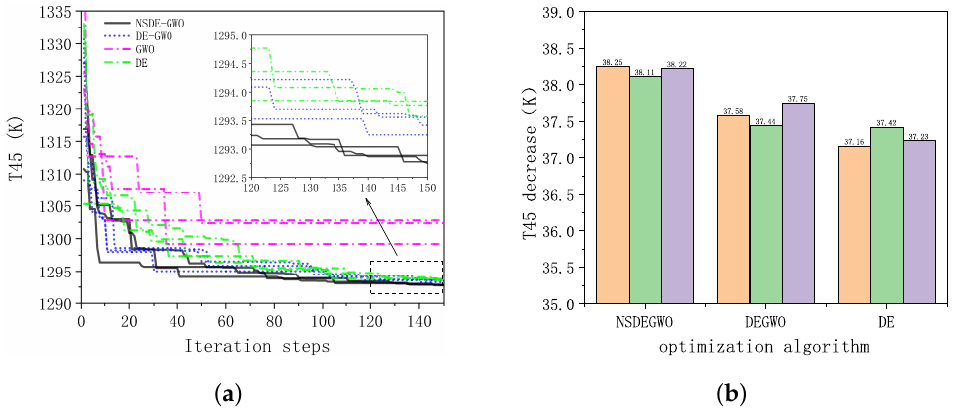
Figure 7. ( a ) Optimization effect of minimum turbine temperature control of four intelligent algo- rithms (DE, GWO, DE-GWO, and NSDE-GWO). ( b ) Histogram of T45 increase percentage.